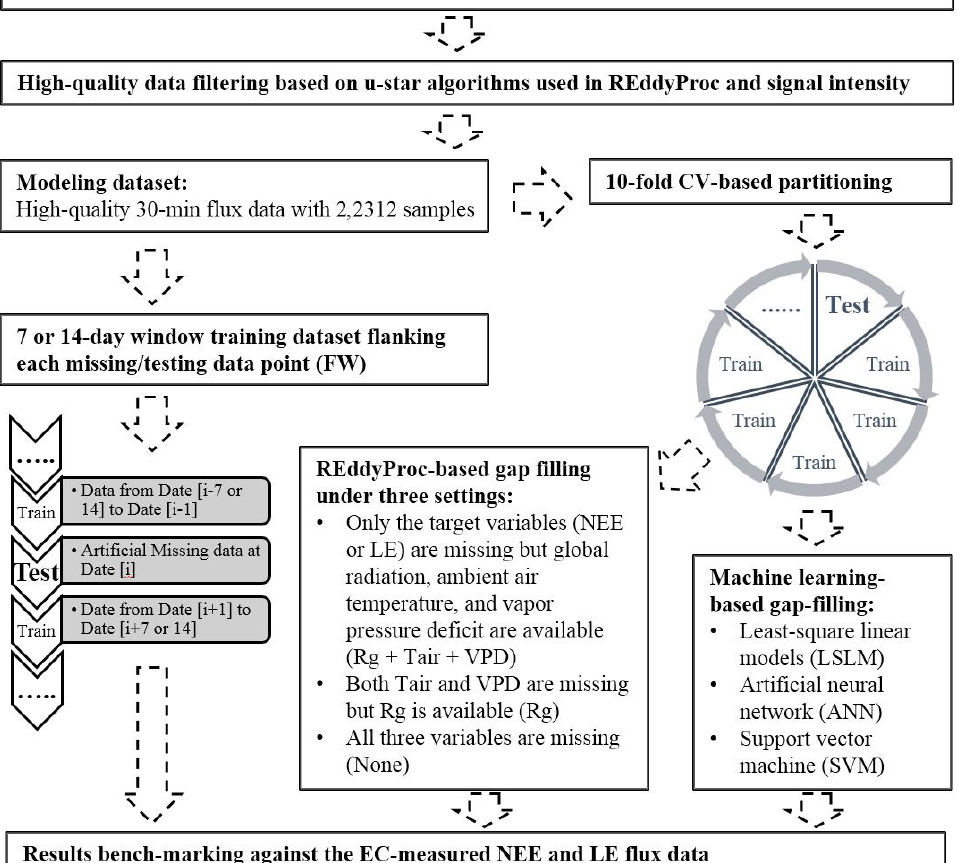
Figure 2. The overall data analysis scheme and logic flow of the net ecosystem exchange (NEE) and latent heat flux (LE) gap-filling and uncertainty analysis.